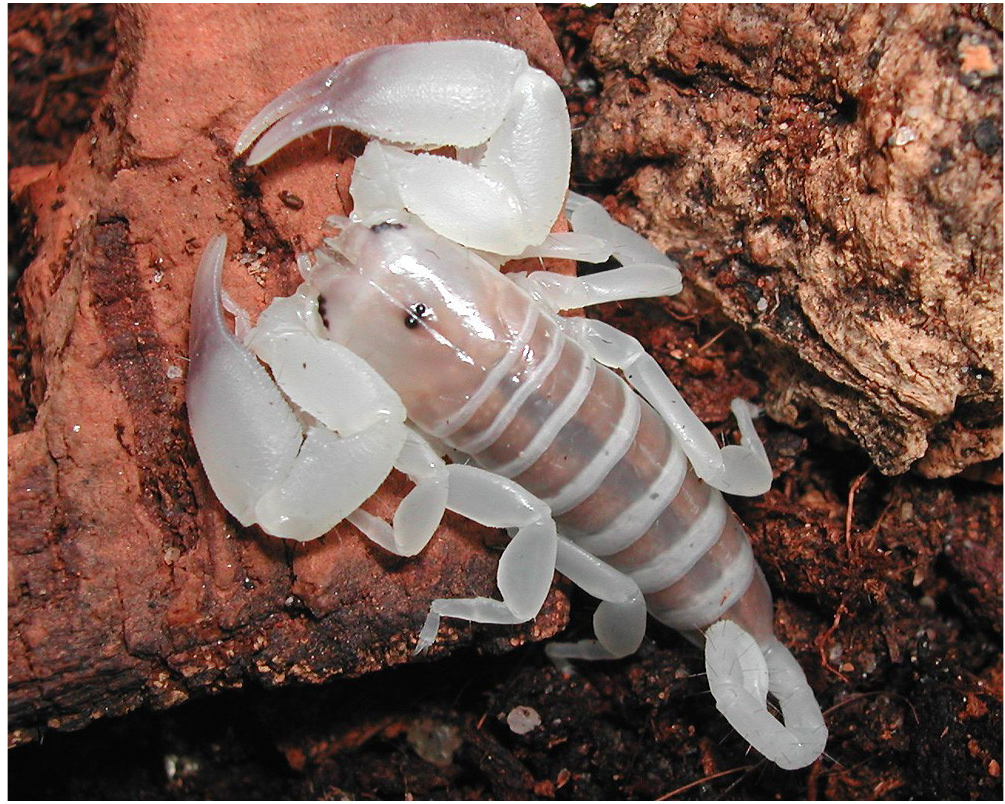
Figure 4. Palaeocheloctonus septentrionalis Lourenço & Wilmé, pre-adult male from Madagascar. A Hormuridae scorpion with bulky pedipalps and a diminutive metasoma (copyright by E. Ythier, reproduced with permission).